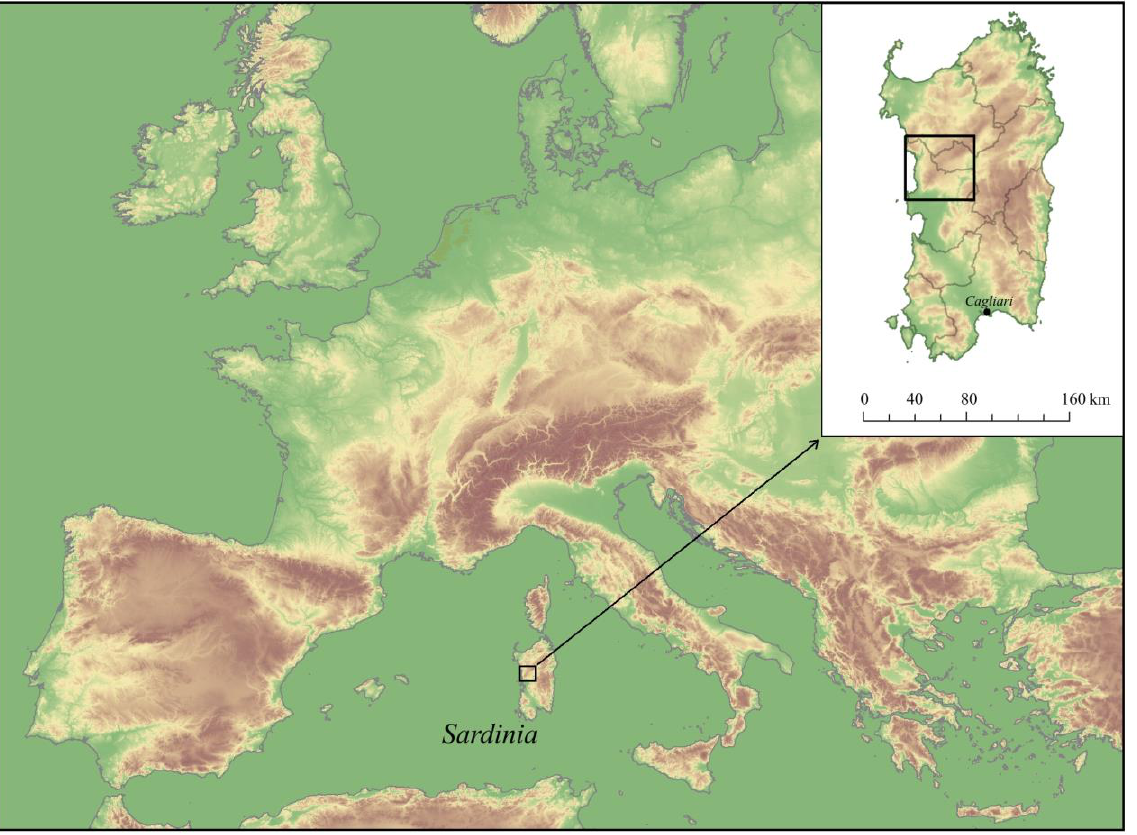
Figure 1. Sardinia and the study area (Elaboration of the Authors on the basis of a raster map of the European Environment